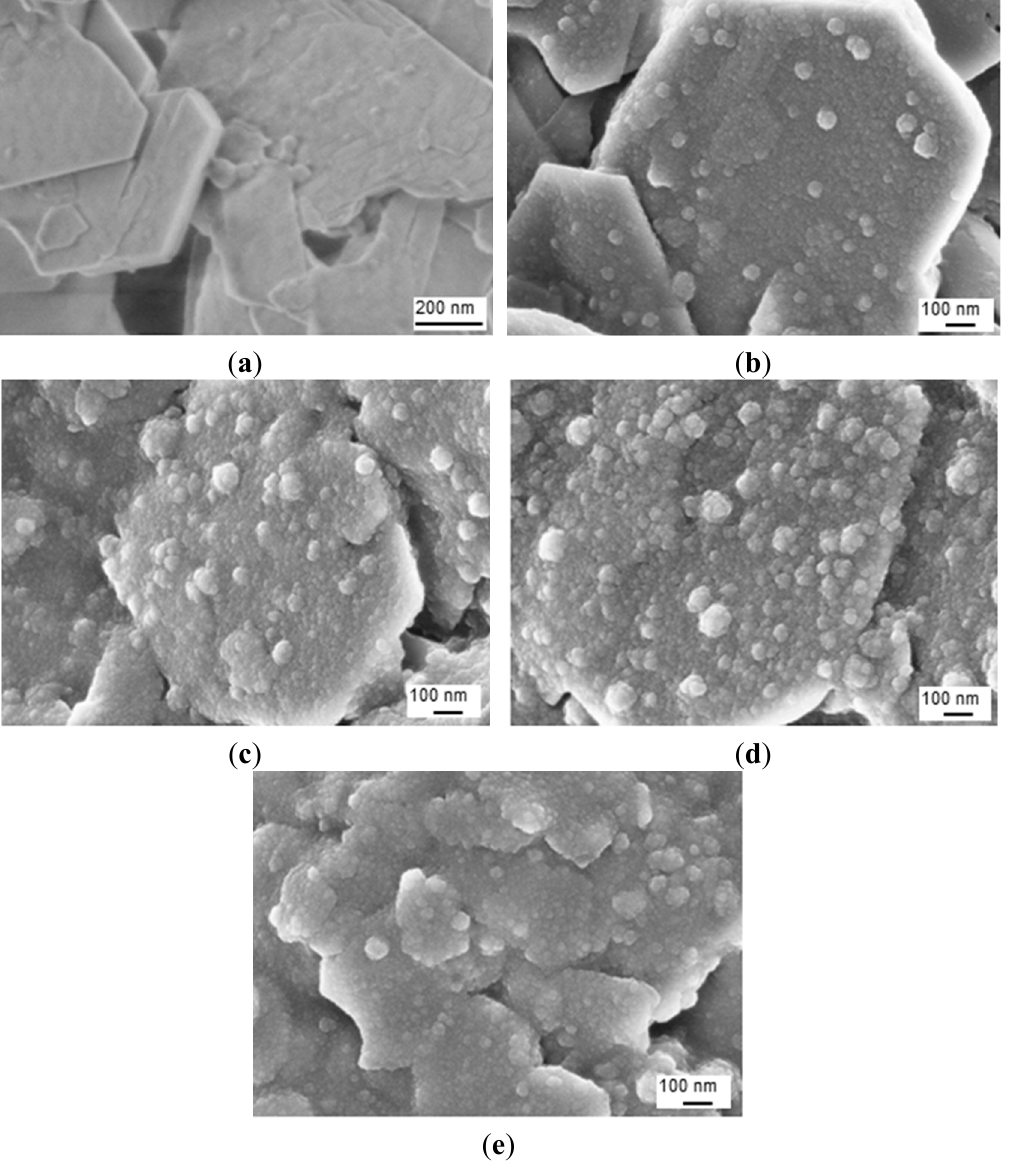
Figure 8. SEM images of surface-modified kaolinite nanocomposite platelets after chemical reaction for ( a ) pure Kln, ( b ) Kln/SMI = 95:5, ( c ) Kln/SMI = 80:20, ( d ) Kln/SMI = 70:30, ( e ) Kln/SMI =